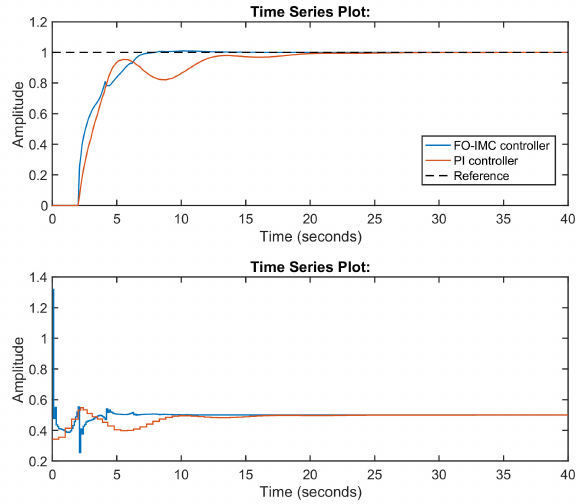
Figure 10. Comparison between the closed loop systems with the event-based FO-IMC and the PI controllers for reference tracking (output signal in the upper plot, input signal in the lower plot).